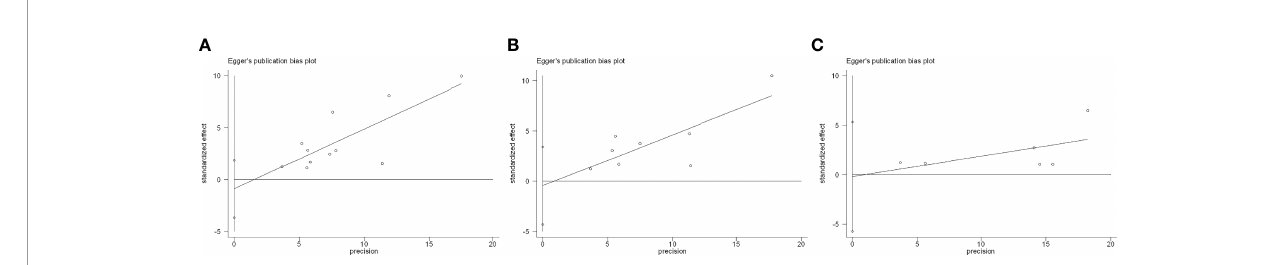
FIGURE 10 | Egger ’ s test for included studies. (A) Flare. (B) De novo immune-related adverse event (irAE). (C)